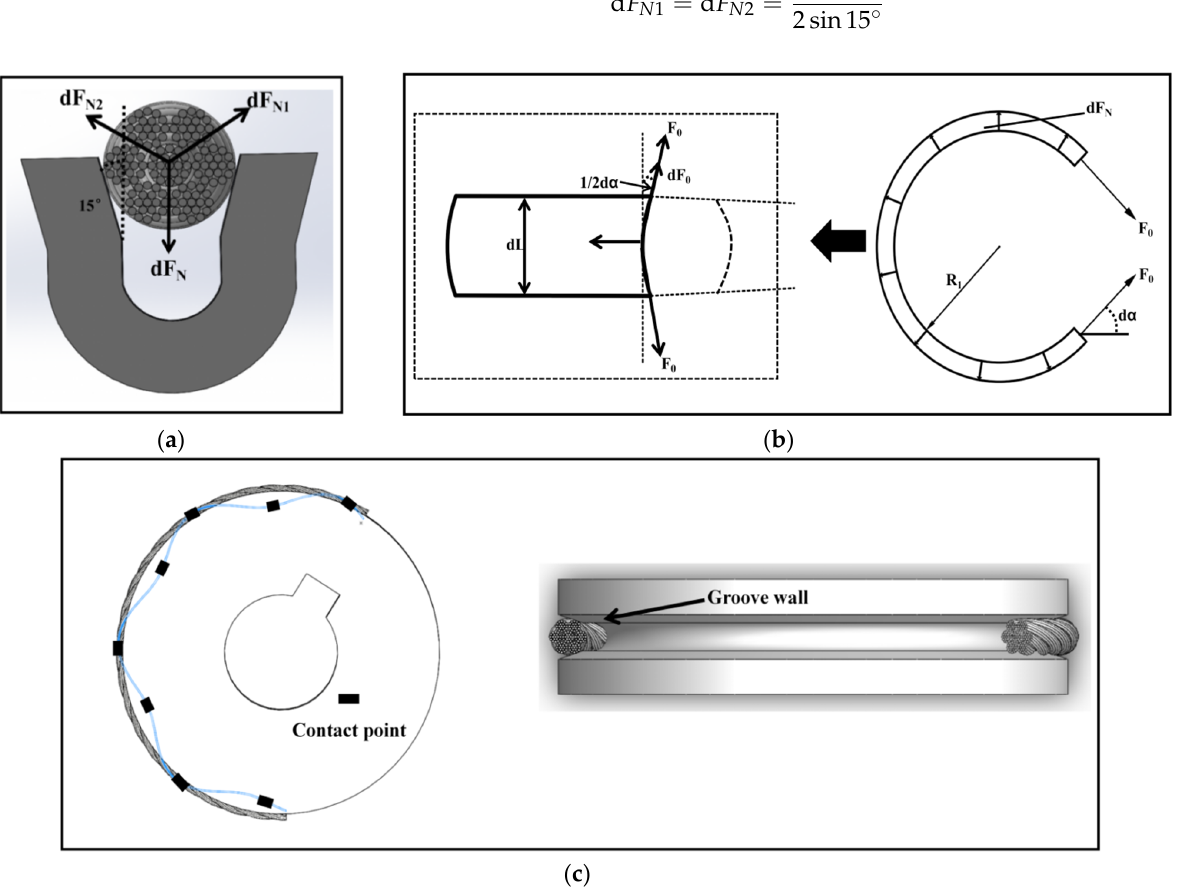
Figure 7. Force analysis diagram of wire rope when the microsegment was stationary. ( a ) Force analysis of wire rope and driving wheel. ( b ) Stress analysis of microsection wire rope. ( c ) Rope–wheel contact model. Table 1. Parameters of wire rope.